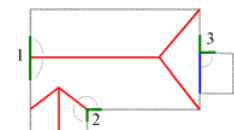
Figure 6: Outer bounds fixing with roof skeleton